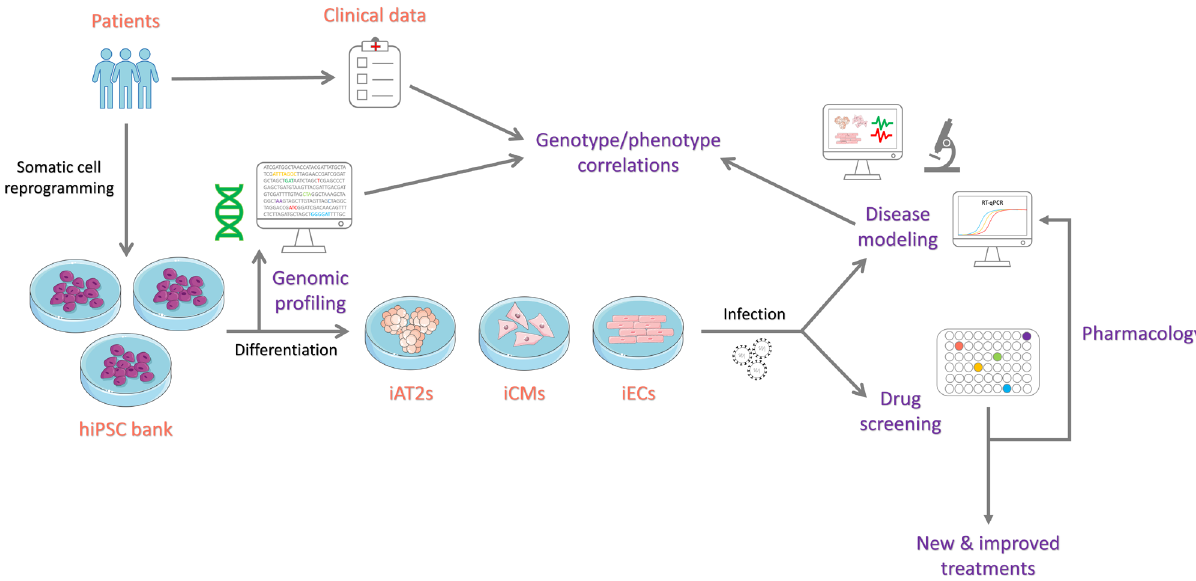
Figure 1 – The potential uses of human induced pluripotent stem cells (hiPSCs) in COVID-19 research. Human iPS-derived cell types relevant for COVID-19 - alveolar type 2 epithelial cells (iAT2s), cardiomyocytes (iCMs) and endothelial cells (iECs), can be used for drug screening/repurposing and disease modeling. A hiPSC-bank of the Brazilian genetic admixture allows for the functional investigation of the role of host-genomics in SARS- CoV-2 infection and in COVID-19